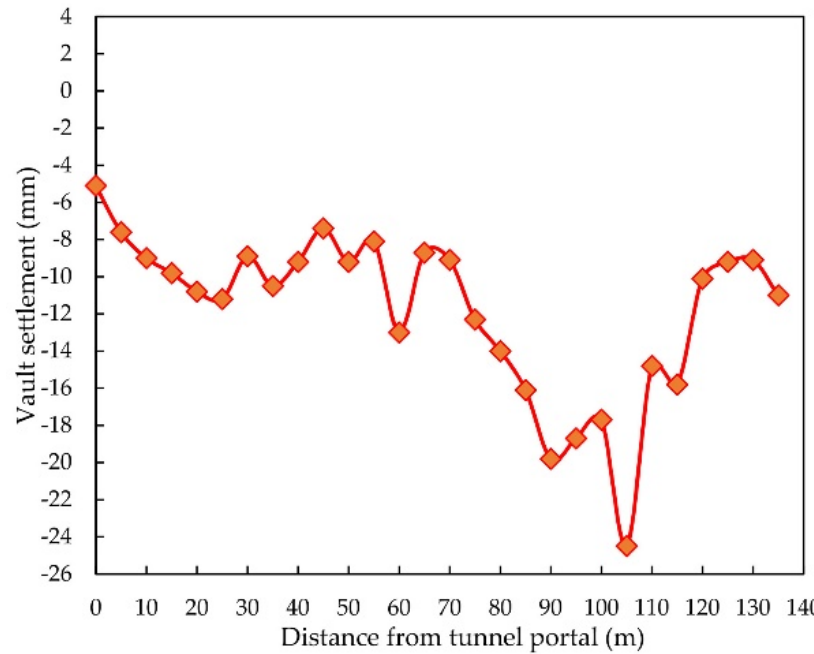
Figure 12. Settlement of the left tunnel vault in the field.